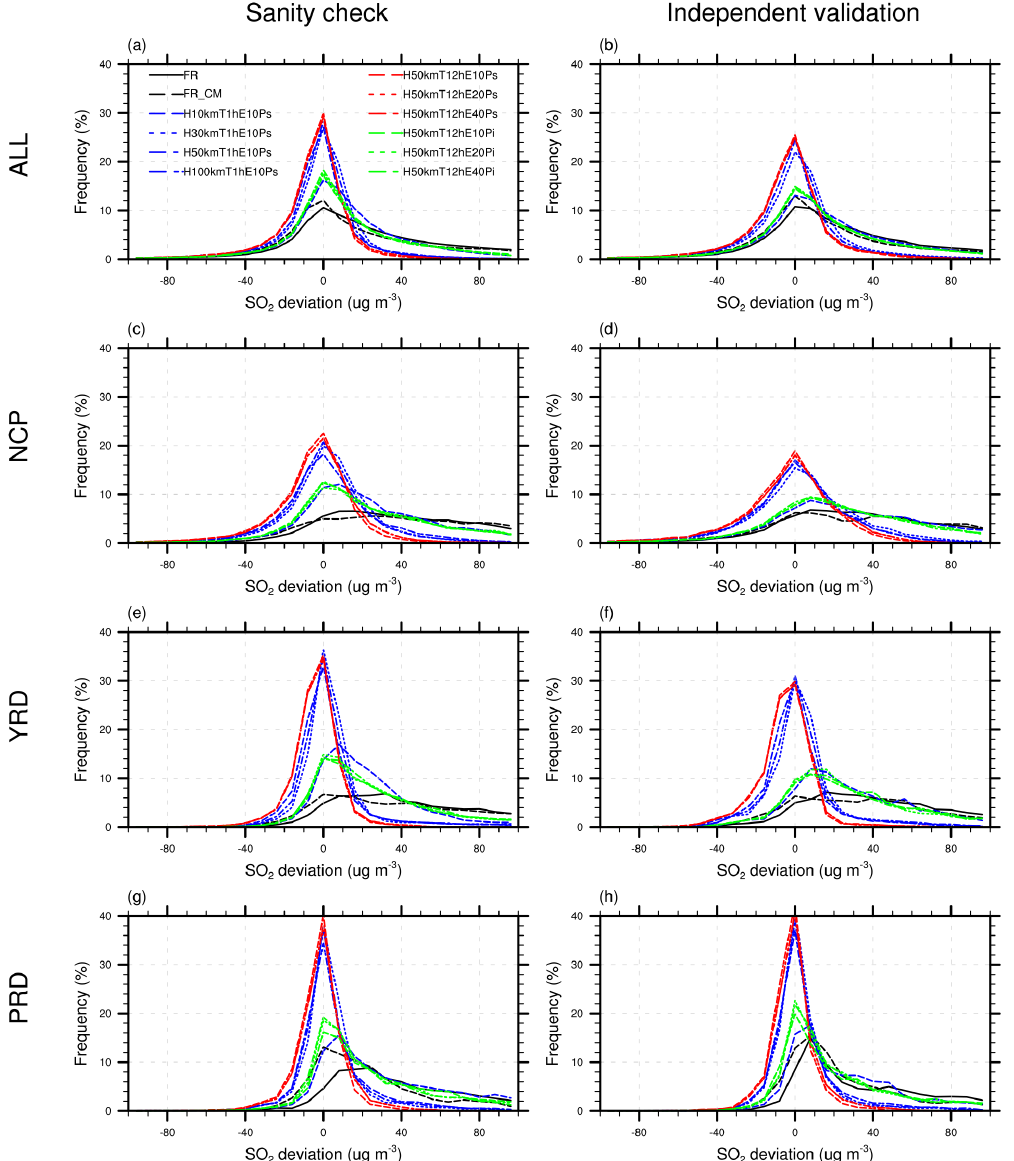
Figure 8. Frequency distributions of the deviations of the simulated SO 2 surface concentrations in various experiments minus the observed